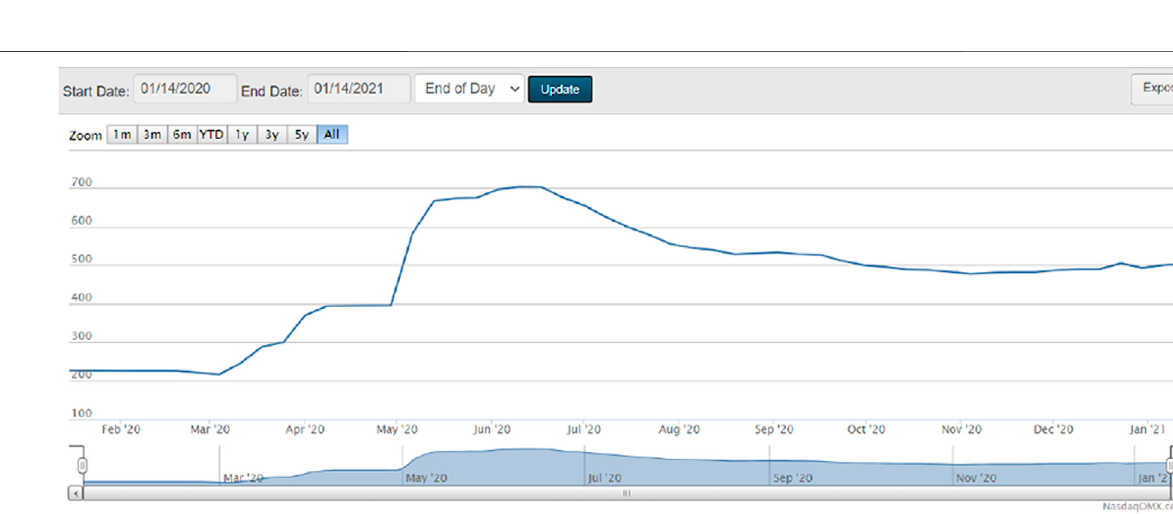
Frontiers in Environmental Science |